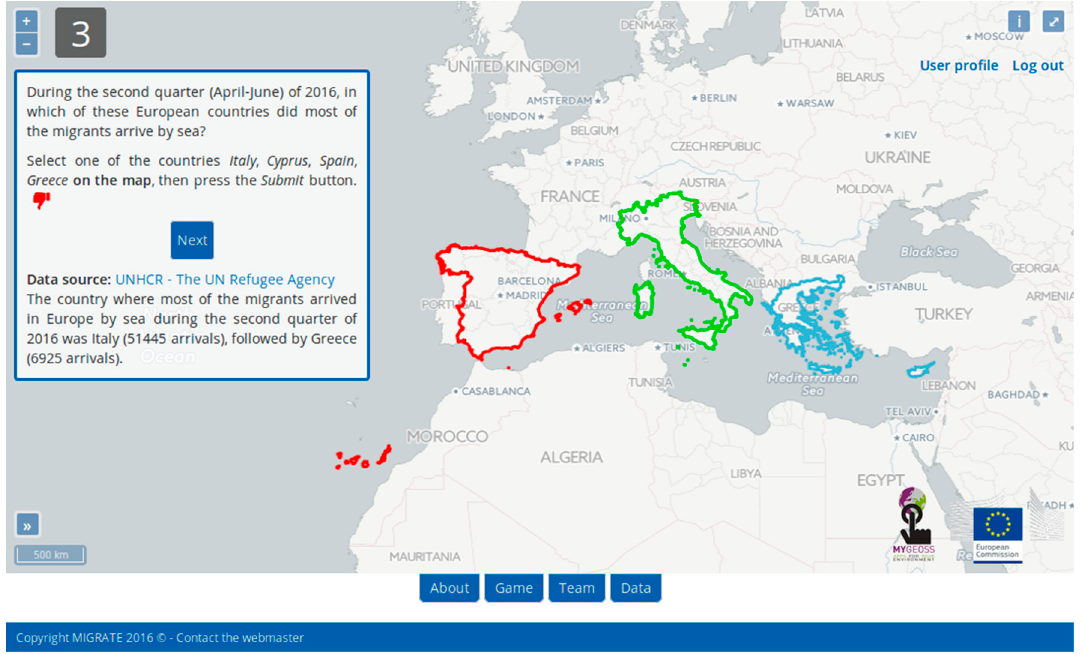
Figure 4. The Migrate Project web site: webgame for educating people on the topic of migration [16,17].